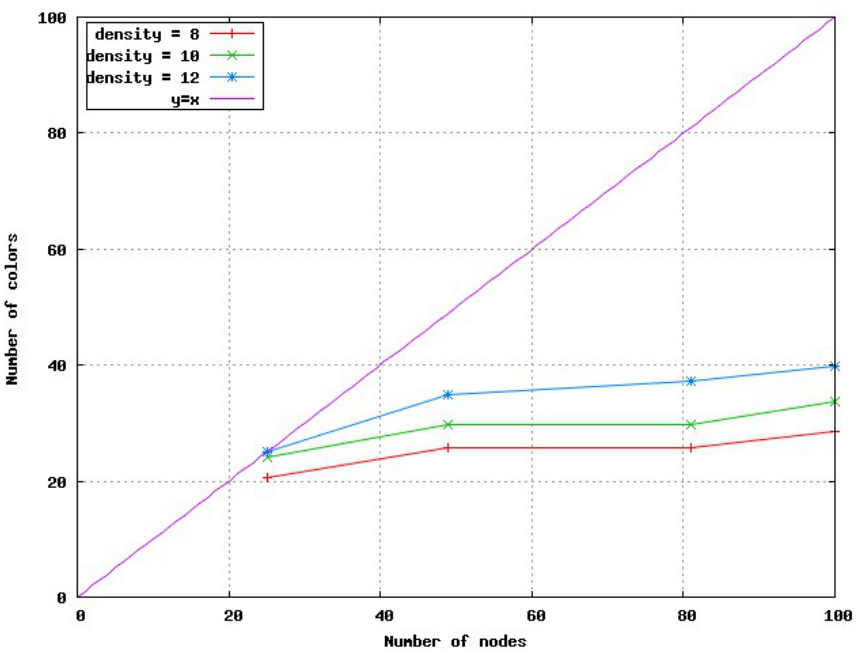
Figure 7. Number of colors in a general